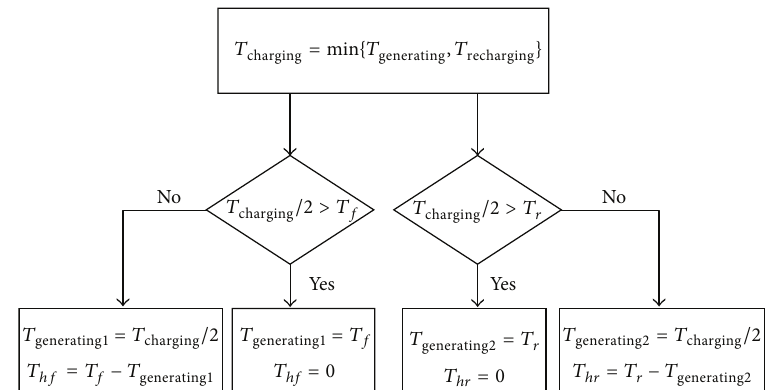
Figure 5: The reallocation strategy.